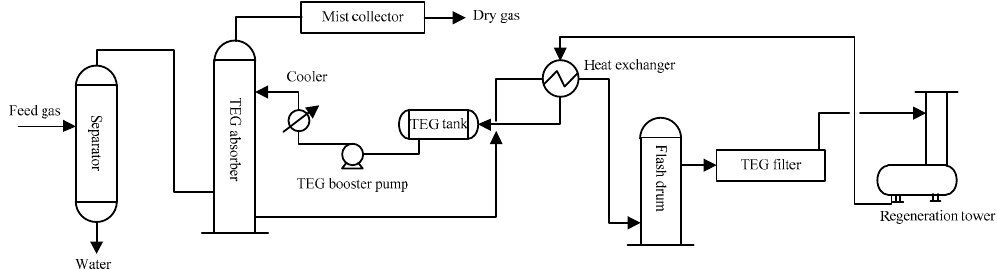
Figure 1. Conventional triethylene glycol (TEG) dehydration process.